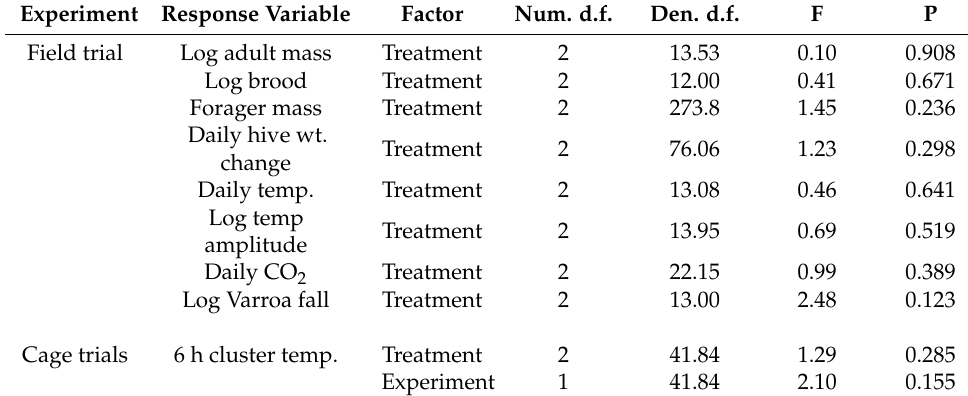
Table 2. Statistical results for flonicamid treatment.